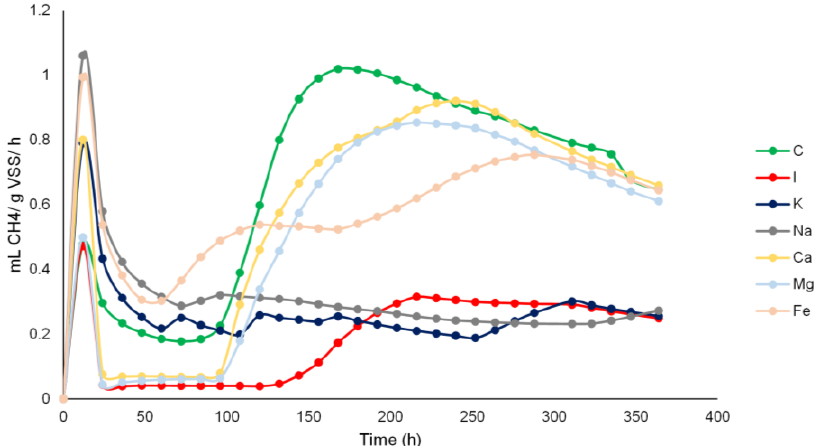
Figure 3. Maximum methane production rates of positive control (C), inhibition group (I) and salt addition groups; of calcium (Ca), magnesium (Mg), iron (Fe), sodium (Na) and potassium